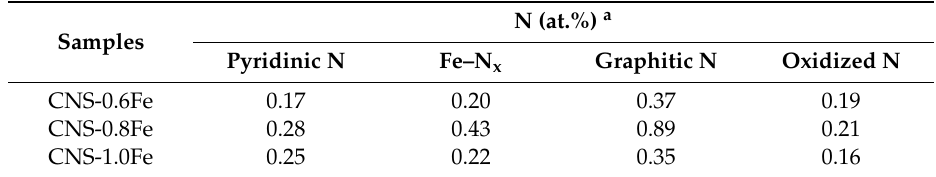
Table 2. Contents (at.%) of nitrogen with di ff erent chemical environments calculated from the N1s XPS spectra.